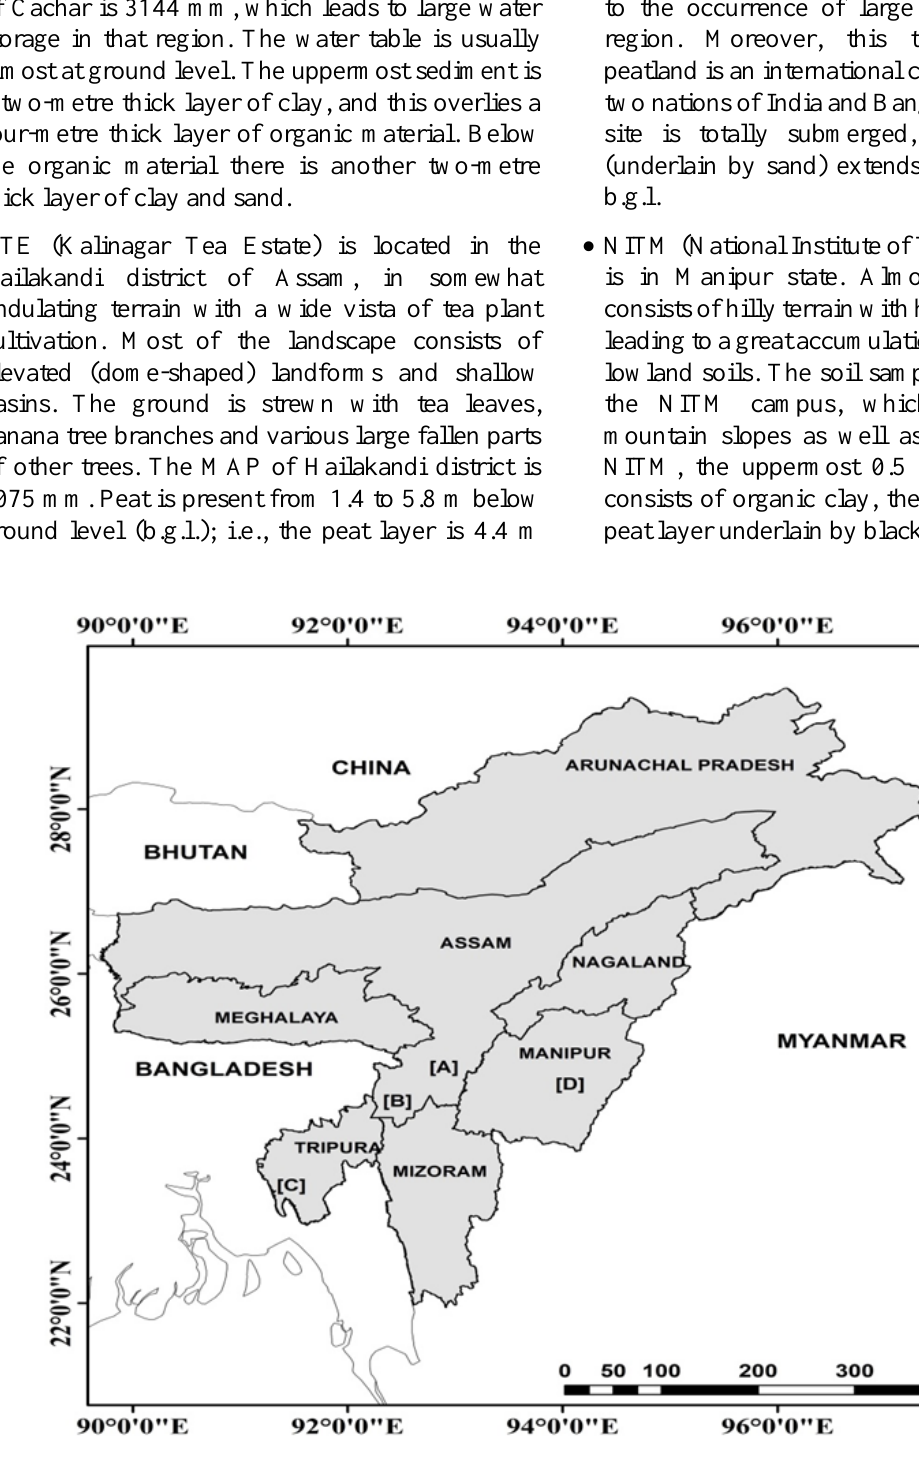
Figure 2. The locations of the four sampling sites within the states of Northeast India: (A) = NH39; (B) = KTE; (C) = IBB; (D) =